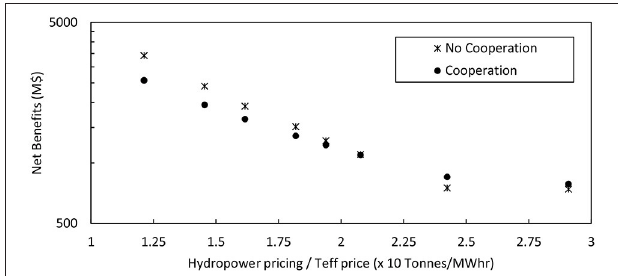
FIGURE 10 | Illustration of the trade-off between agriculture and hydropower and the optimal allocation in the UBN basin. The horizontal axis shows the additional agricultural water consumption compared to the current water land use, while the vertical axis shows the additional benefits either added to agriculture or lost from hydropower corresponding to that consumption. The green curve shows the net benefits added to agriculture if additional water is allocated to agriculture while the blue line shows the net benefits lost from hydropower corresponding to this extra water allocation to agriculture.